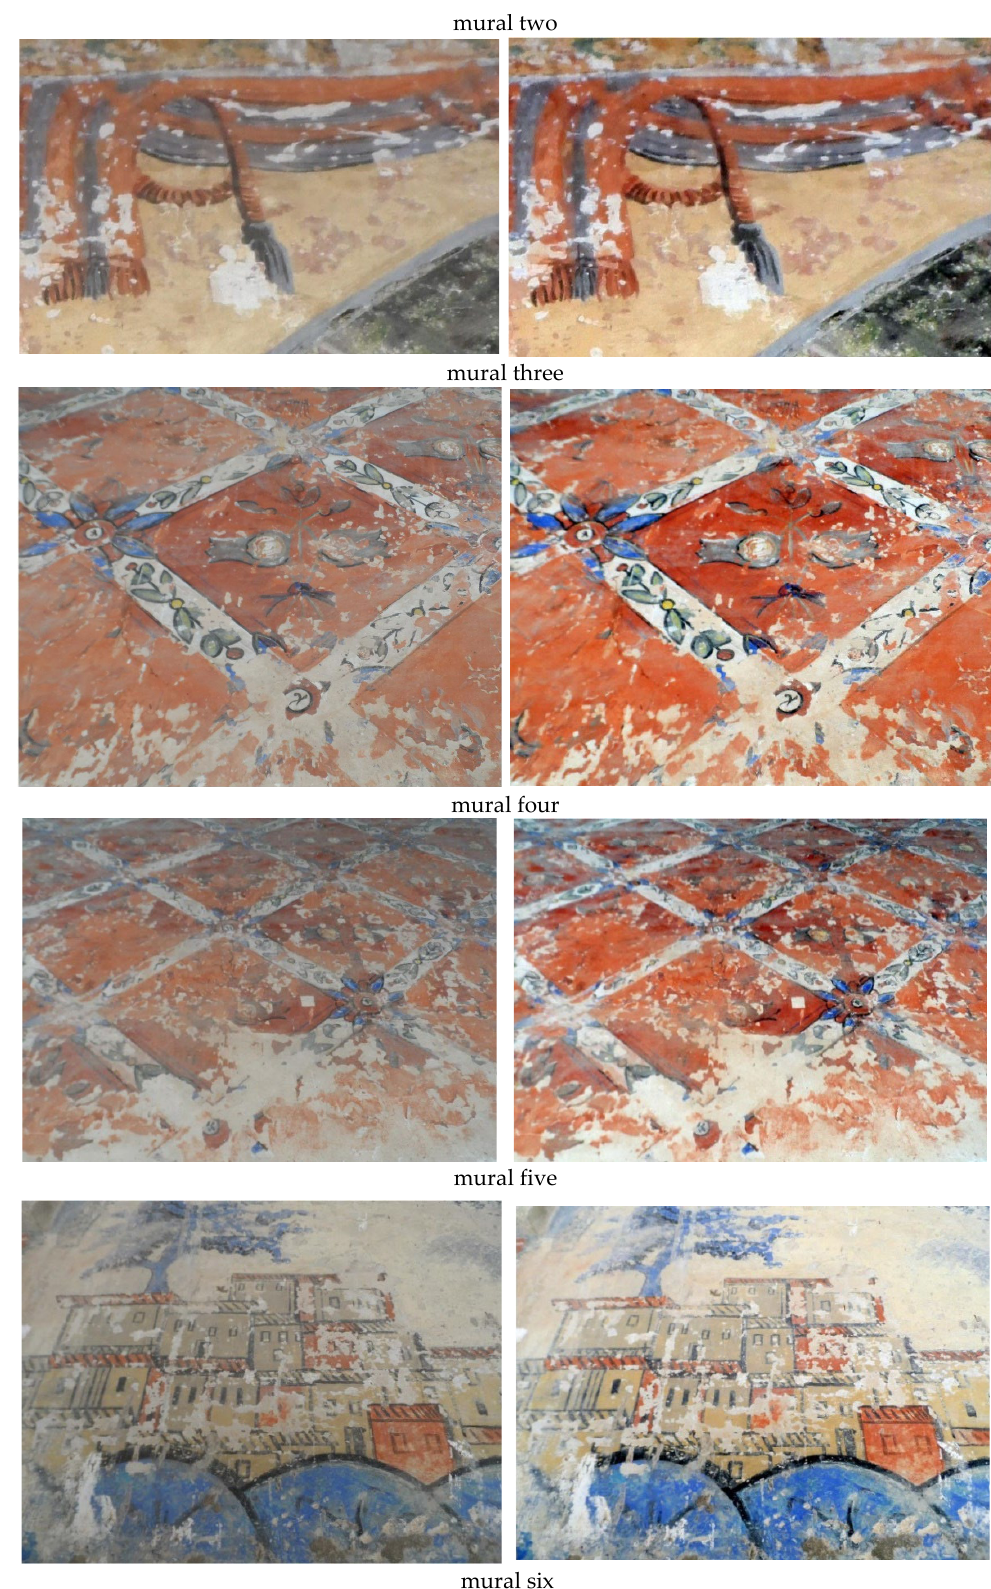
Figure 10. The original and the results of enhancing of murals 2, 3, 4, 5, and 6 using DCP.